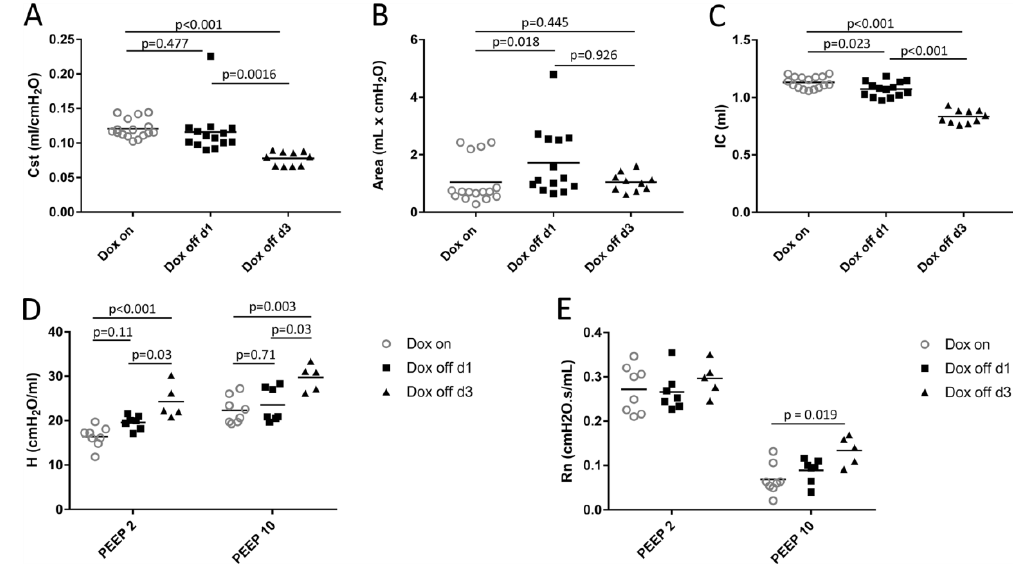
Figure 1. Lung mechanical properties. Quasi-static compliance ( A ), and hysteresis of quasi-static PV loops ( B ), inspiratory capacity ( C ), tissue elastance ( D ), and Newtonian resistance ( E ). PEEP: positive end-expiratory pressure.